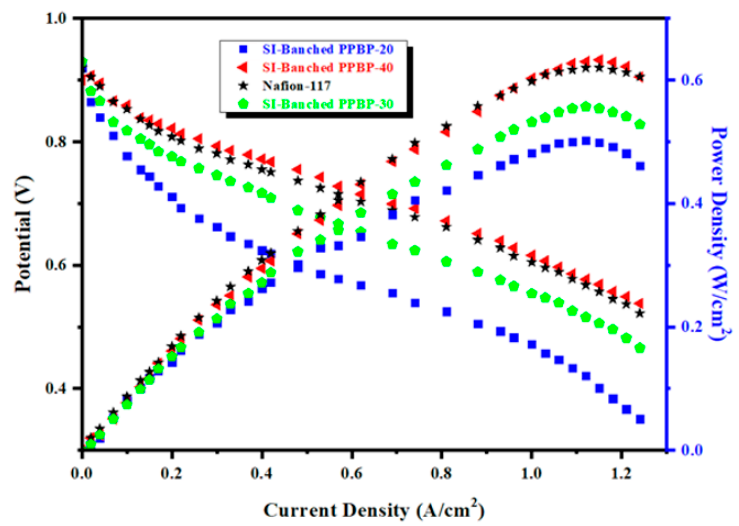
Figure 8. Cell performance for the SI-branched PPBP polymer